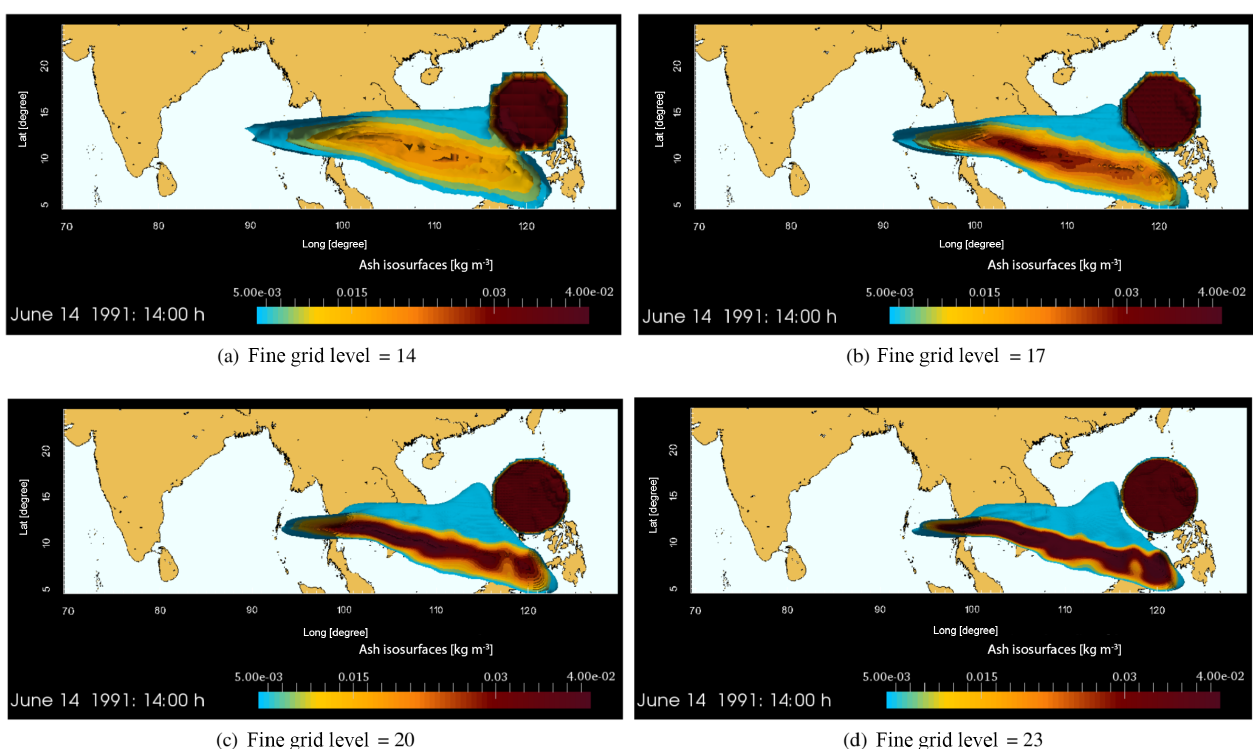
Figure 3. Horizontal cross section of the ash cloud at a height of 17km, modeled with a fine-mesh level of 14, 17, 20 and 23. Re- sults for 14 June at 14:00PHT are shown. The colors indicate ash concentration in kgm − 3 . The minimum displayed ash concentration is 0.005kgm − 3